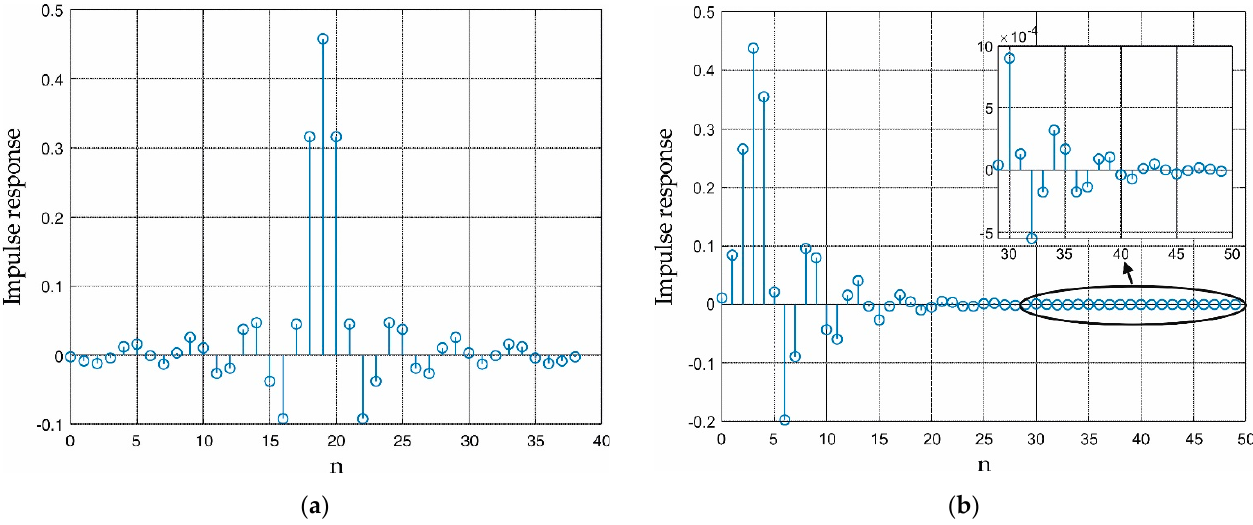
Figure 11. Impulse response of ( a ) the FIR and of ( b ) the IIR unknown filters. The inset shows the tail of the IIR impulse response truncated on the first 50 elements. of the IIR impulse response truncated on the first 50